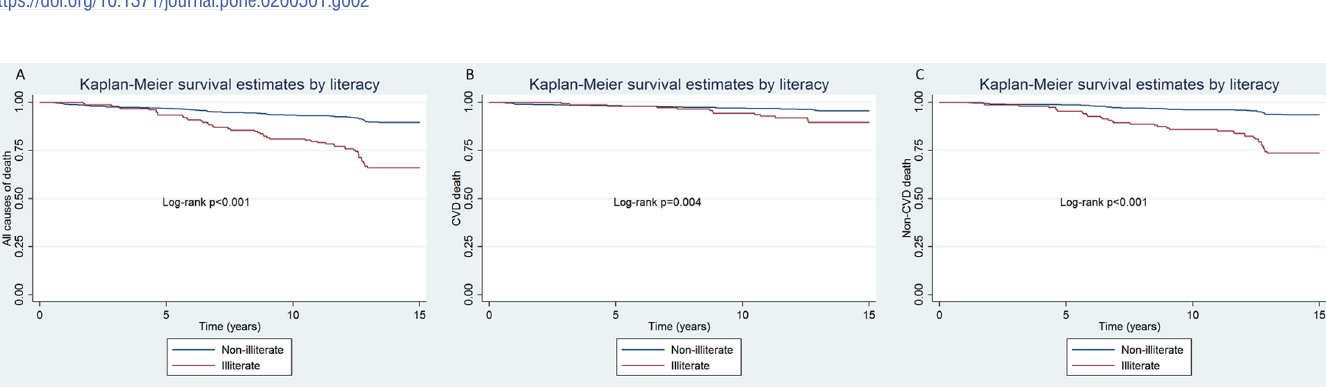
Fig 3. Kaplan-Meier survival curves comparing all causes of death (A), CVD death (B) and Non-CVD death (C) between illiterate and non-illiterate individuals.